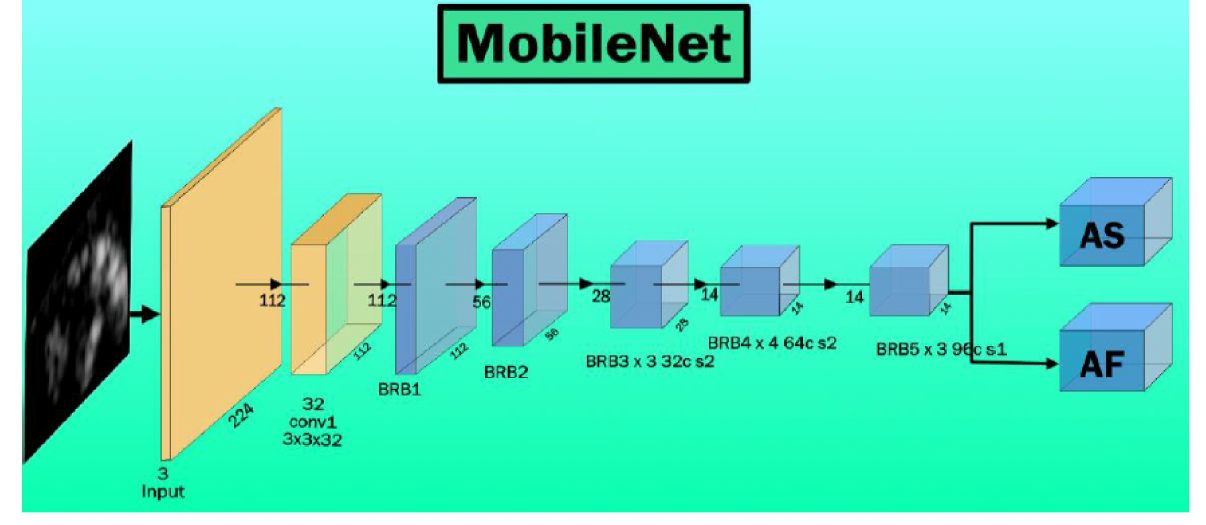
Figure A6. MobileNet architecture, BRB: bottleneck and residual blocks [292].